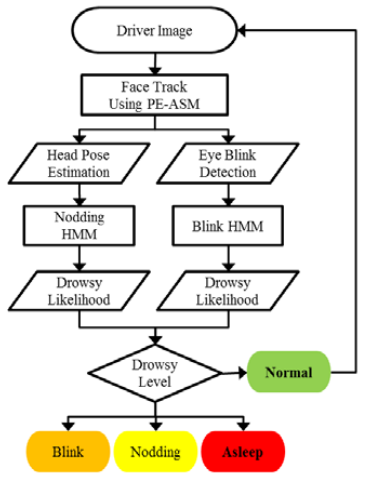
Figure 5. System Flow Chart.